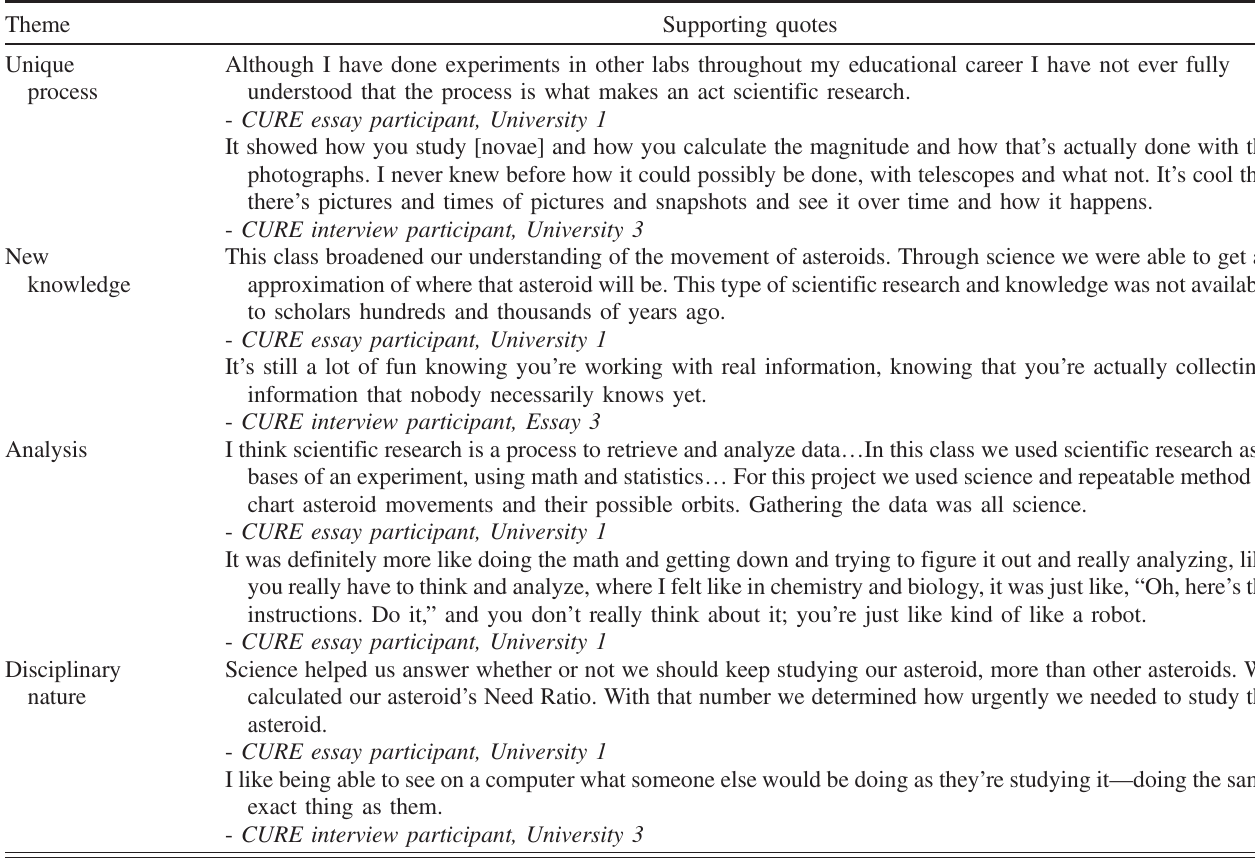
TABLE V. Example quotes expressing themes related to the process of science generated from qualitative analysis characterizing RBSEU instruction as compared to previous science